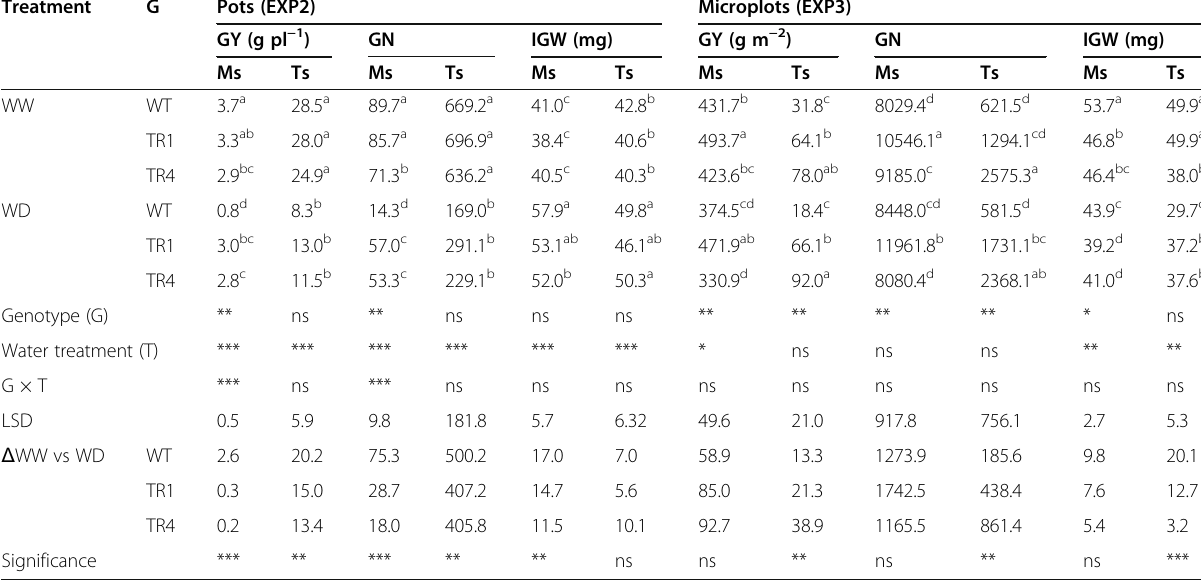
Table 3 Grain yield and its components discriminated for main stems or tillers under greenhouse conditions Treatment G